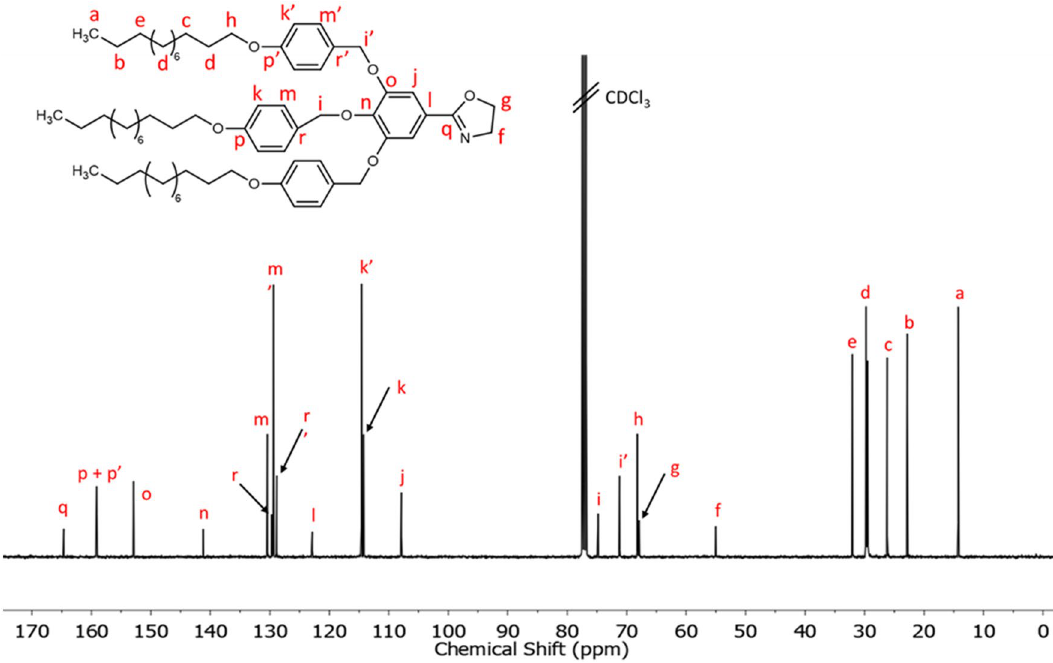
Figure 7. 13 C NMR spectrum in CDCl 3 of